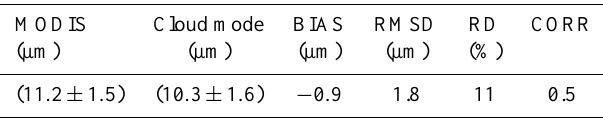
Table 7. Statistics for comparison of cloud effective droplet radius (µm) to MODIS retrievals using eight Terra and Aqua overpasses in May–December 2007. Mean and standard deviation are included in each parenthesis. The metrics include the mean bias (BIAS), root- mean-squared difference (RMSD), relative deviation (RD in %) and correlation